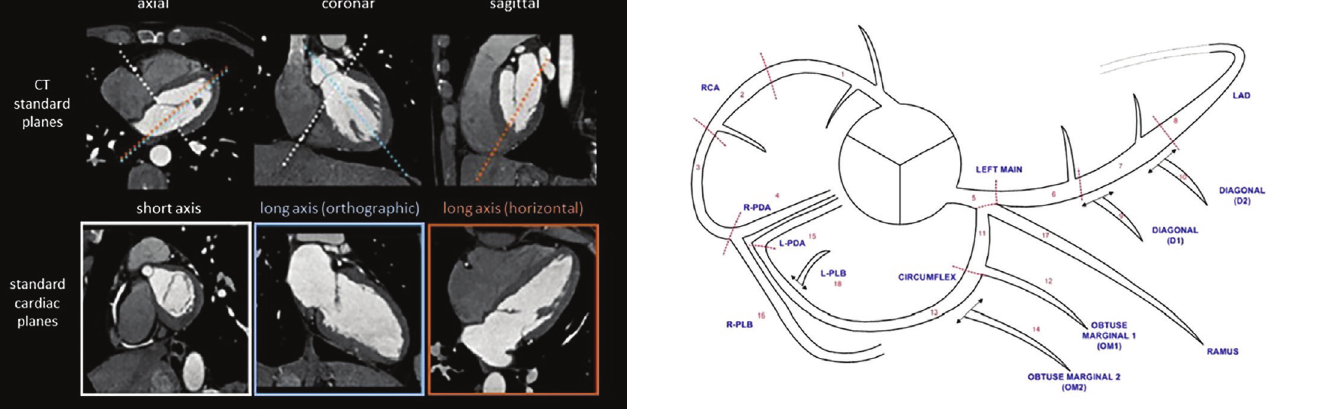
Figure 2. Guidelines for the adjustment of the field of imaging from the standard CT plane to the standard cardiac plane [7].